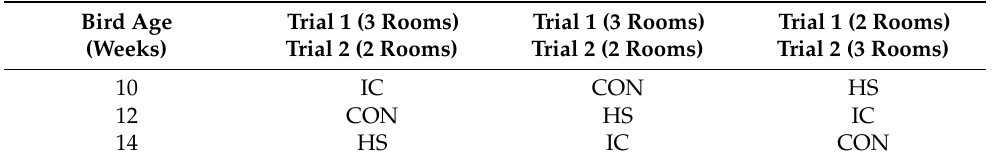
Table 1. Schedule and order of treatments imposed on turkeys in each room: Heat Stress (HS), Immune Challenge (IC), or Control (neither HS or IC; CON). The experiment was run in two trials, with two to three replicate rooms per treatment in each trial (5 replicates/treatment total). Treatments were applied 2 weeks apart, when turkeys were 10, 12 and 14 weeks of